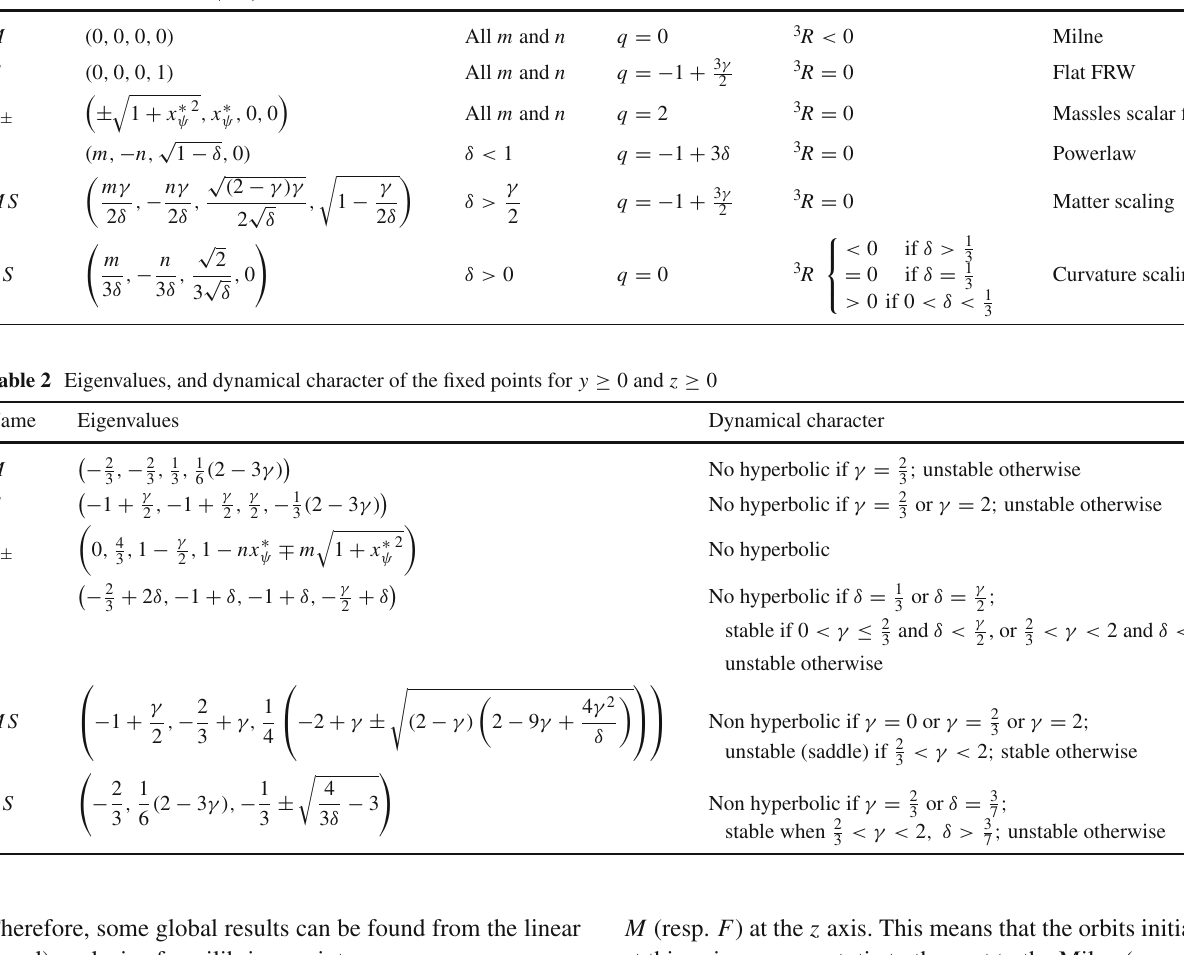
Table 1 Location, existence and some properties of the equilibrium points for z ≥ 0, and y ≥ 0 . We use the notation δ = m 2 − n 2 Label